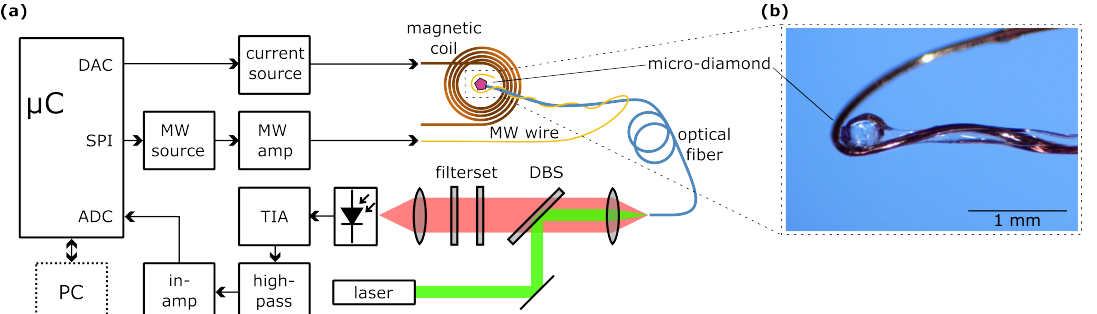
Figure 2. ( a ) Schematic of the ODMR experimental setup. By applying a microwave frequency sweep to the micro-diamond with NV centers, ODMR spectra are acquired using the built-in ADC of the microcontroller. ( b ) The fiber-coupled NV micro-diamond is fixed onto the tip of the optical multimode fiber with UV-cured adhesive. A 100 µ m wire is wrapped around the fiber and brought into close proximity with the micro-diamond for MW